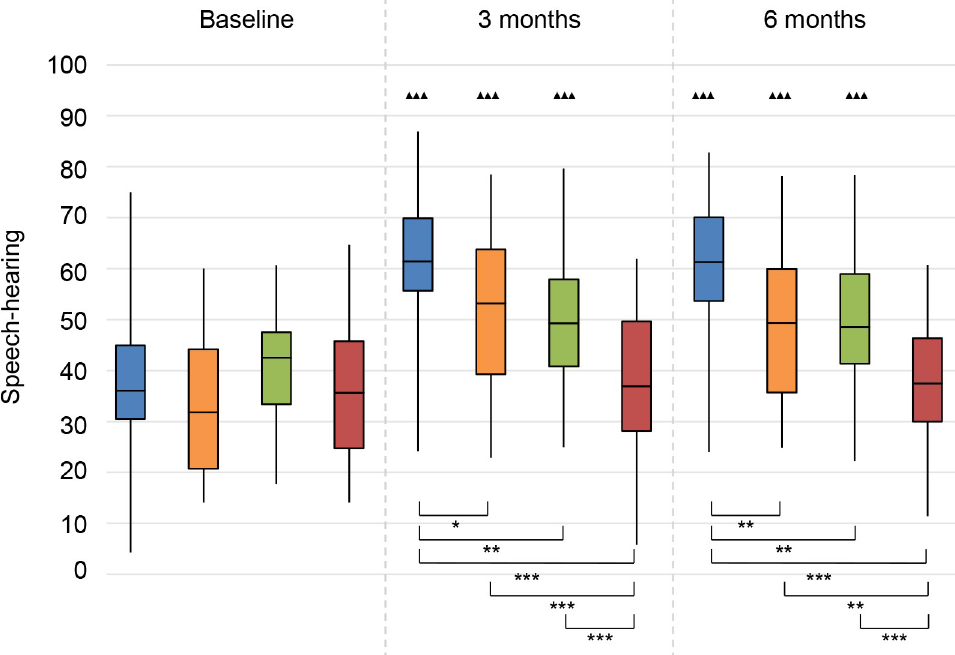
Fig 10. Speech, Spatial and Qualities of hearing questionnaire (SSQ). Speech-hearing subscale. Statistical difference compared to baseline. ▲▲▲ = p < 0.001; ▲▲ = p < 0.01; ▲ = p < 0.05. Statistical difference compared to 3 months follow-up. ■■■ = p < 0.001; ■■ = p < 0.01; ■ = p < 0.05. Statistical difference between groups at same follow-up moment. ��� = p < 0.001; �� = p < 0.01; � = p <